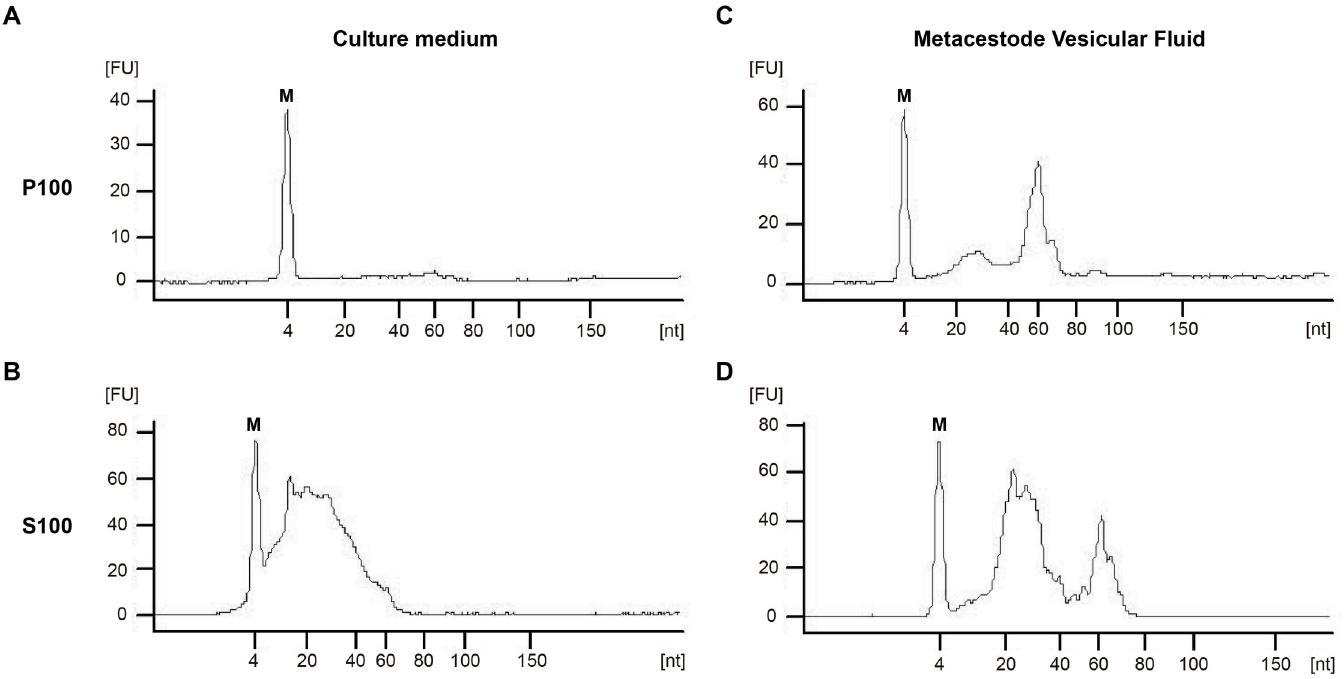
Fig 3. Echinococcus multilocularis extra- and intra-parasite secretions contain sRNAs. Analysis of the sRNA content ( < 200 nt) present in the P100 and S100 fractions of culture medium (A, B) and metacestode vesicular fluid (C, D) of E . multilocularis active metacestodes. M: marker. FU: fluorescence units.